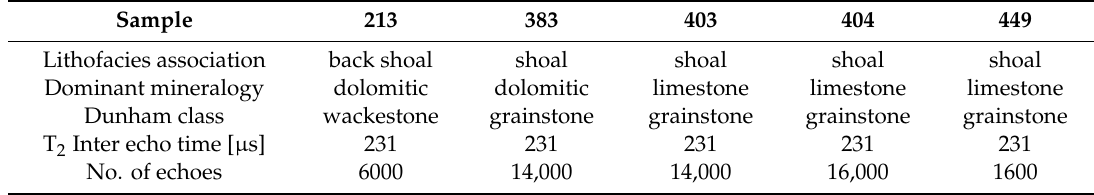
Table 2. Nuclear magnetic resonance (NMR) measurement